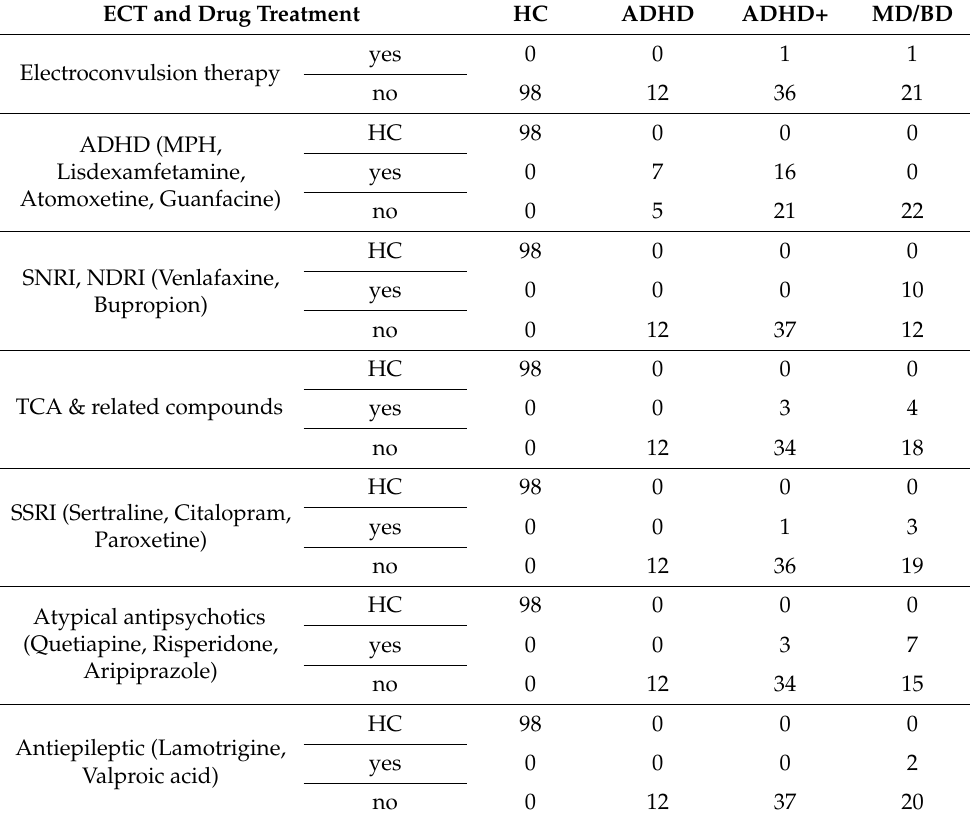
Table 3. Electroconvulsion therapy (ECT) and drug treatments. ECT and Drug